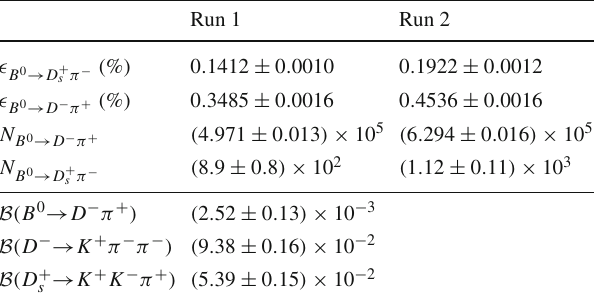
Table 3 Results of B 0 → D + s π − and B 0 → D − π + signal efficiencies and yields, as well as the branching fractions used as input for this measurement